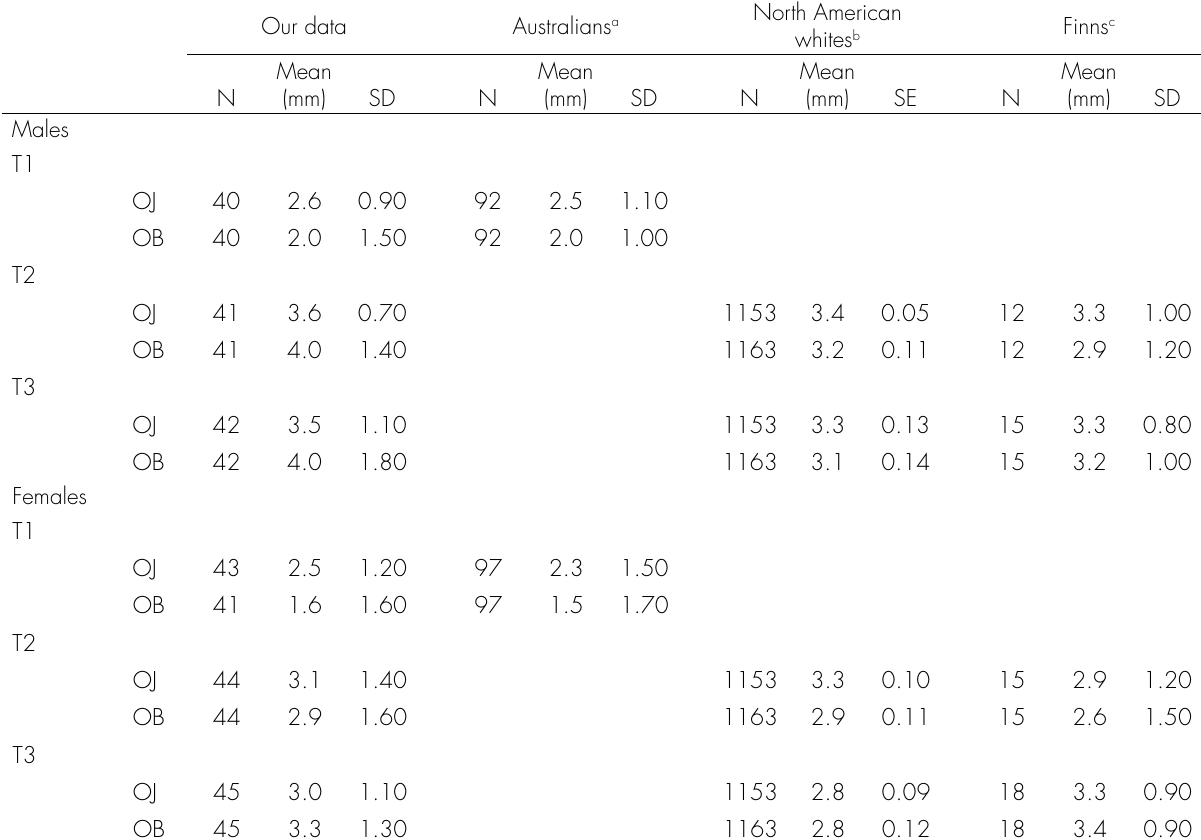
Table III. Overjet (OJ) and overbite (OB) values in the primary, mixed and permanent dentitions of males and females in different populations measured in